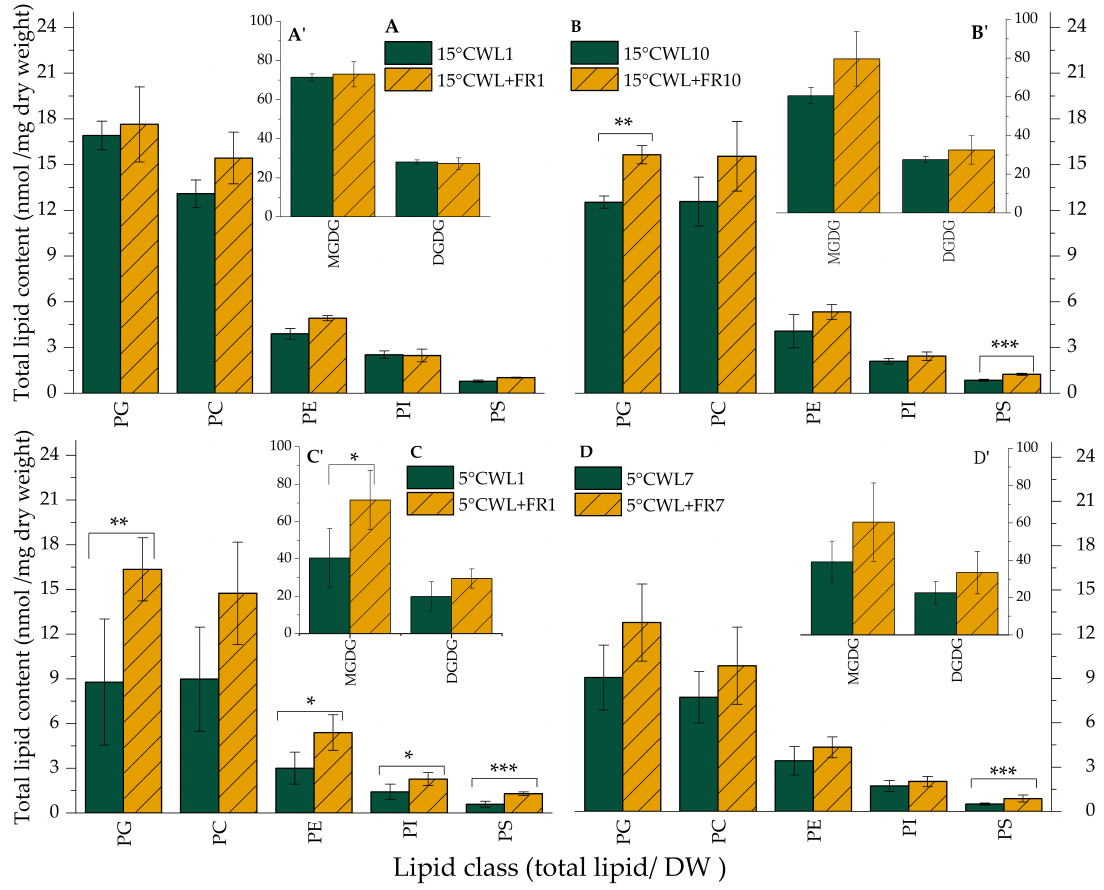
Figure 4. Lipid class distribution of barley “Nure” leaves grown at 15 ◦ C for 1 day ( A , A’ ) and for 10 days ( B , B’ ), as well as in leaves grown at 5 ◦ C for 1 day ( C , C’ ) and for 7 days ( D , D’ ) under WL and WL + FR. Mean values ± SD were calculated from 3 independent biological replicates. Significance levels are designated as * p < 0.1, ** p < 0.05, *** p <